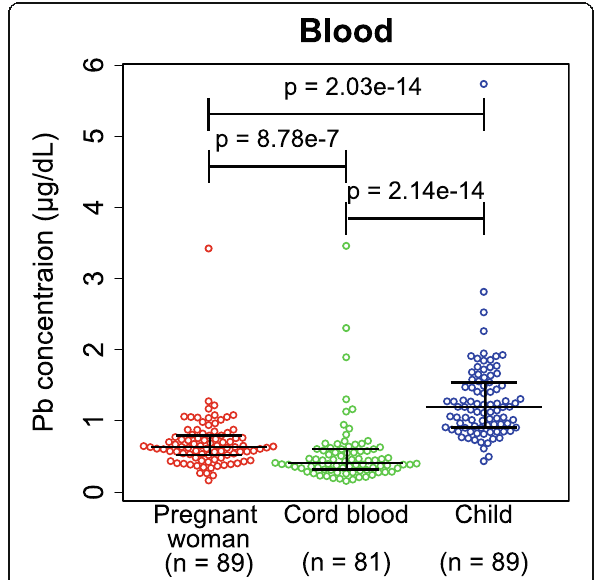
Fig. 2 Lead concentration in blood of pregnant women, cord blood, and children. Lead concentration in peripheral blood of pregnant women and children and cord blood collected when the pregnant women ’ s delivery. Medians (longer horizontal lines) and 1st and 3rd quartiles (lower and higher horizontal lines, respectively) were indicated in the graph. Lead exposure of pregnant women and children were compared using with Steel-Dwass test. The p values were indicated in the graph